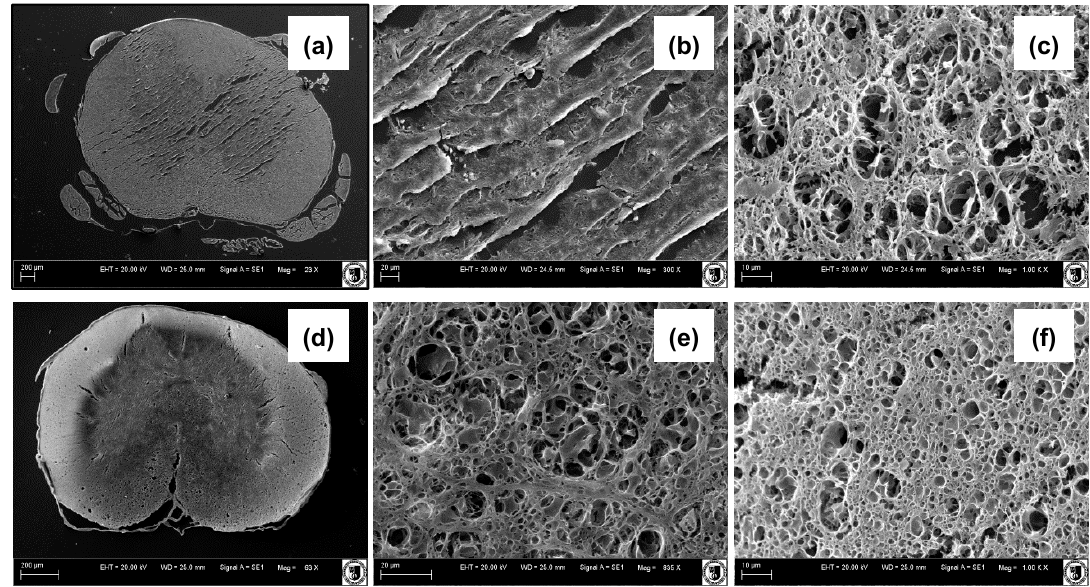
Figure 1. SEM images of rat ( a – c ) and leopard gecko spinal cord ( d – f ) at the thoracic level: general view ( a , d ), gray matter ( b , e ) and white matter ( c , f ).